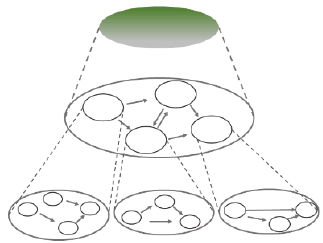
Figure 5: Schematic representation of a multi-level mechanism. Figure 5. Schematic representation of a multi-level